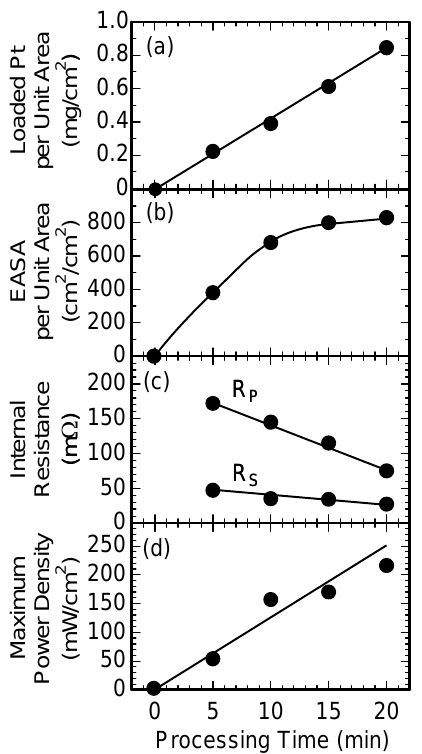
Figure 8. The dependence of the in-liquid plasma processing time on ( a ) the weight of the loaded Pt; ( b ) the electrochemically active surface area (EASA) of the Pt catalyst per unit area (1 × 1 cm 2 ) of the cathode and electrode; ( c ) the parallel resistance (R p ) and series resistance (R s ); and ( d ) the maximum output power density for the fuel cells.